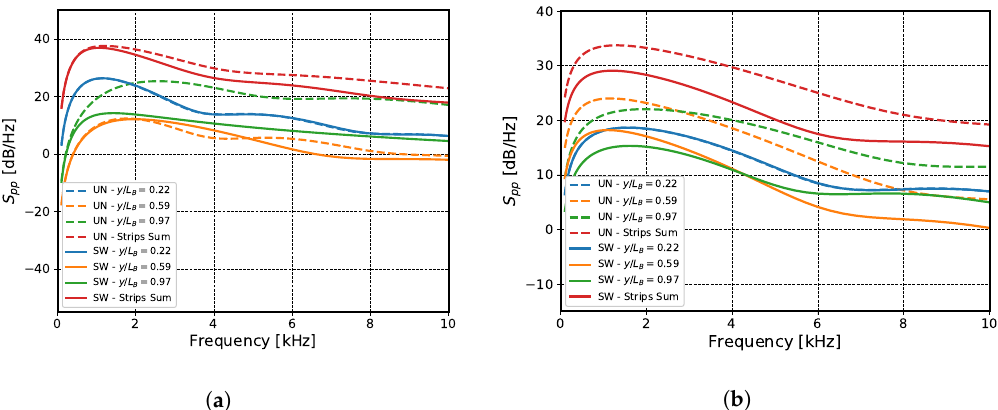
Figure 10. Far-field sound power-spectral density (PSD) distribution over the blade span. The dashed curves represent the classical Amiet’s theory, whilst the solid ones take into account the varying sweep-angle: ( a ) leading-edge noise prediction case, ( b ) trailing-edge noise prediction